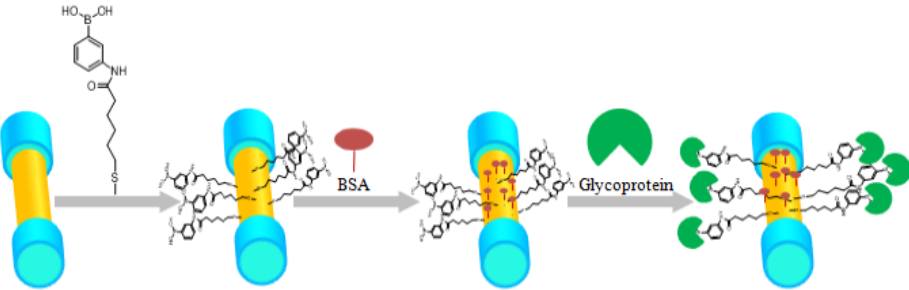
Figure 22. The process of protein identification and immobilization on the plasmonic sensing region of the biosensor for glycoprotein detection. The sensor was first dipped in boronic acid derivative for 24 h, and then block the unreacted carboxyl by dipping the sensor to the BSA, and different concentrations of glycoprotein. Figure reproduced under the terms of the CC-BY Creative Commons attribution 4.0 from Reference [50], Copyright 2017.